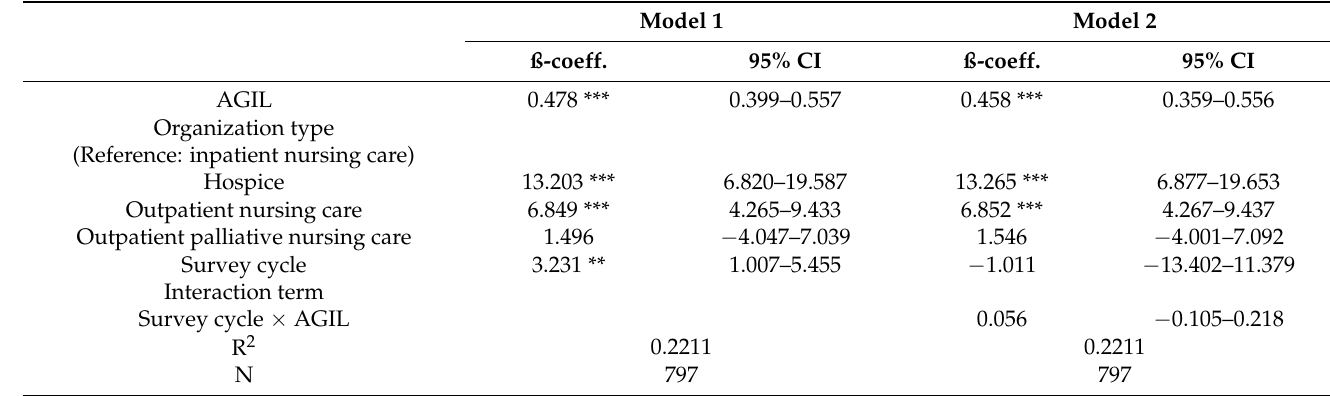
Table 4. Association between AGIL as an independent variable and person-centered care as a Table 3. Sample characteristics by survey cycle. dependent variable controlled for organization type and survey